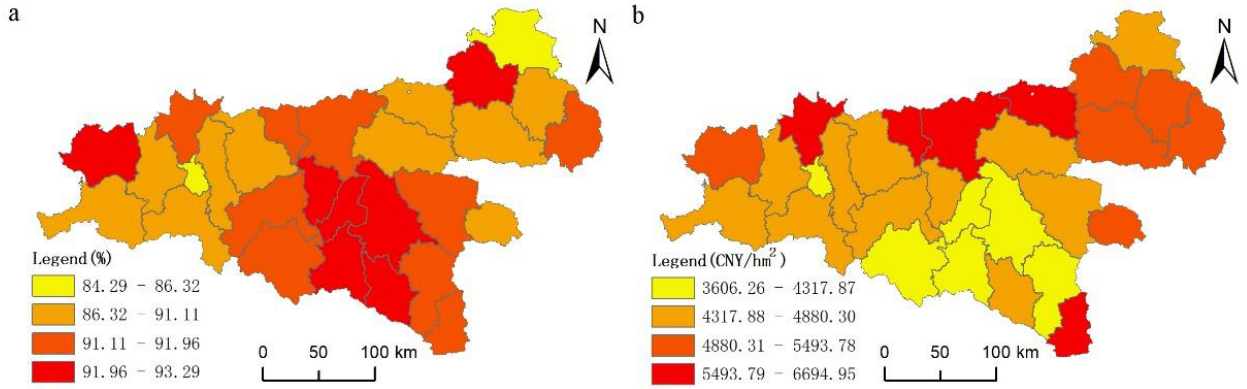
Figure 4. ( a ) Rate of change in ecosystem service value; ( b ) distribution of average ecosystem service value in the Qinba Mountains from 2000 to 2015.